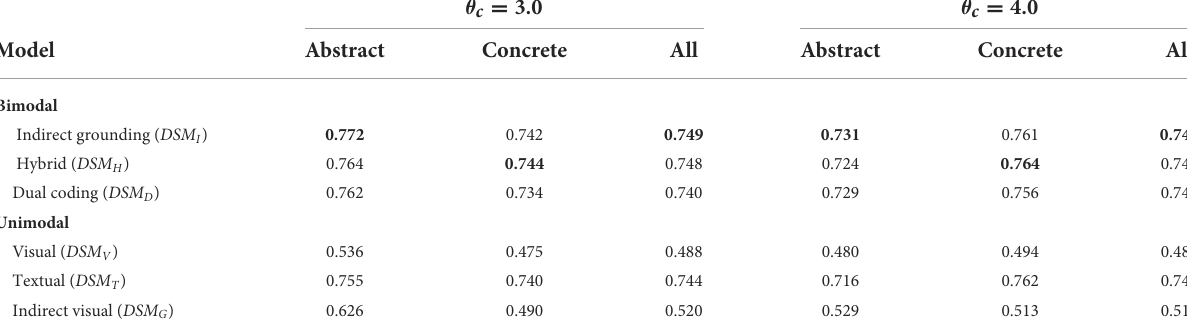
TABLE 5 Mean correlations for the indirect grounding model and other models.